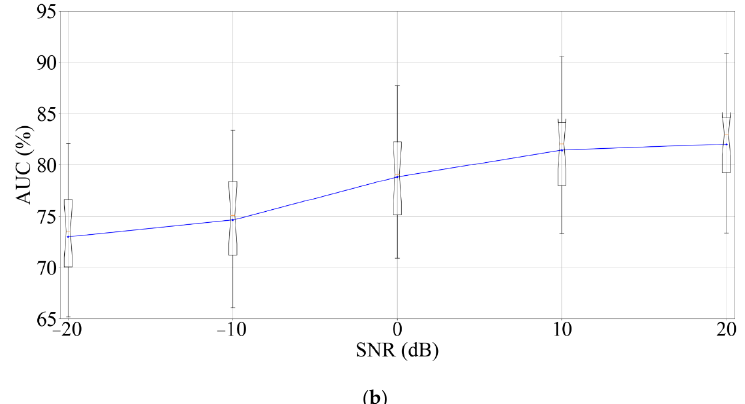
Figure 6. Boxplots indicate the average values for the simulations where AWGN is introduced in the EEG signals, evaluating the 16 subjects using LOO for the models optimized by ( a ) GA, and ( b )